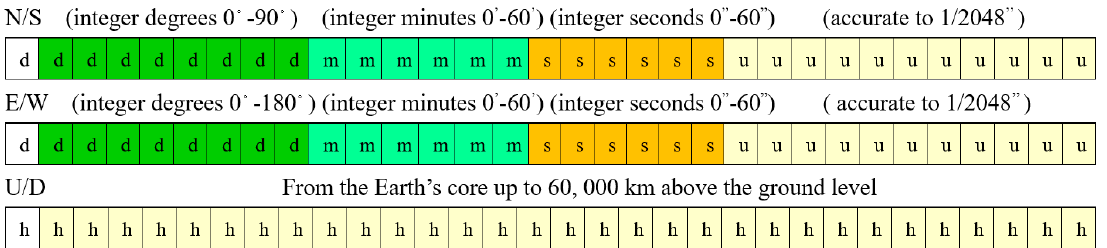
Figure 6. GeoSOT-3D space-filling curves.